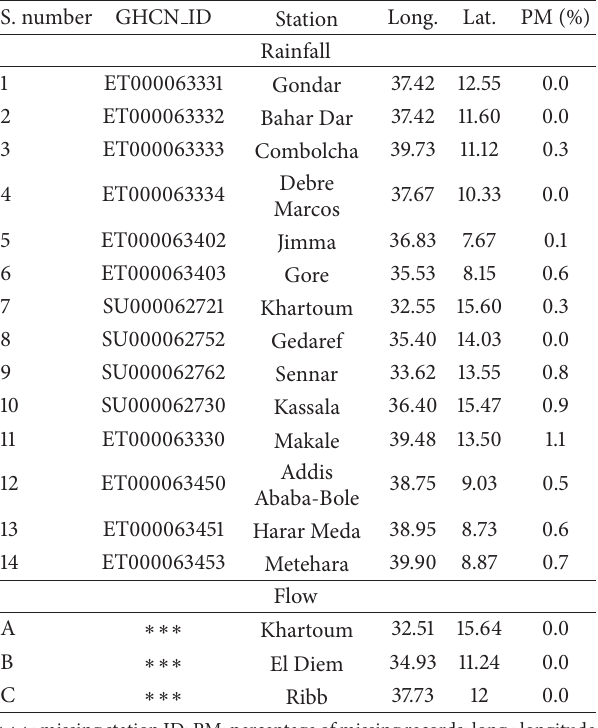
Table 1: Meteorological and hydrological